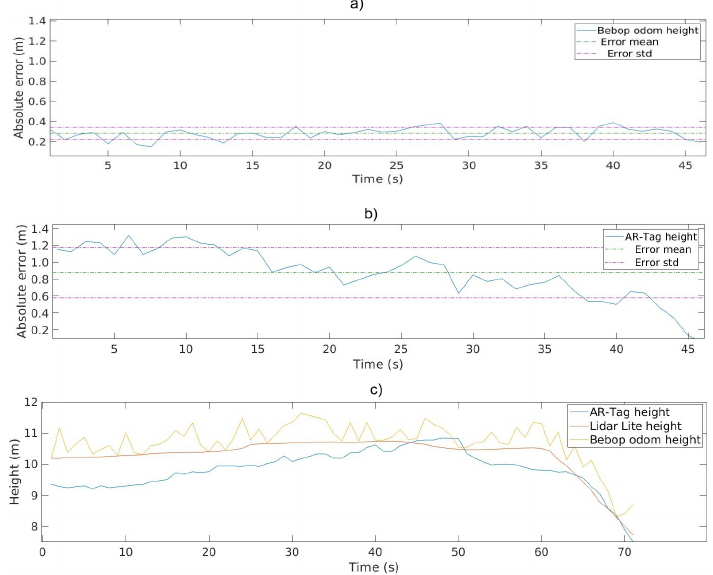
Figure 12. Height evaluation. ( a ) Bebop odometry height error; ( b ) AR-Tag height error; ( c ) height data from the AR-Tag, Bebop, and LIDAR-Lite